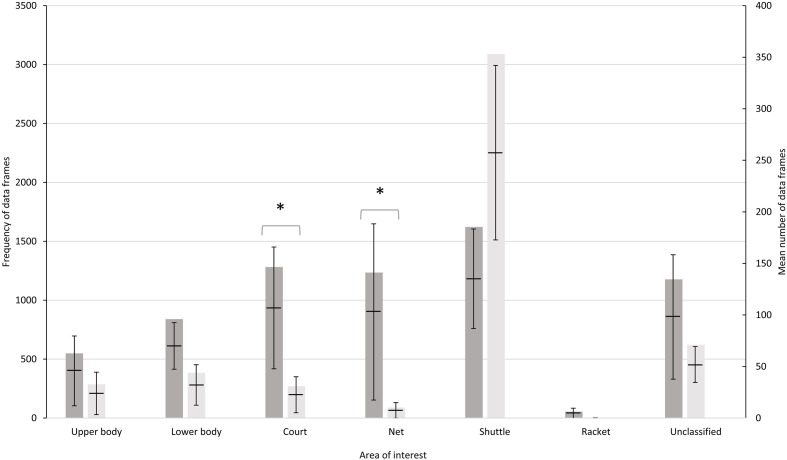
Frequency of data frames, mean (black line) and 95% confidence borders for each AOI for 662 trials for skilled (shaded) and less skilled participants. The asterisks represent significant differences (p < 0.05).